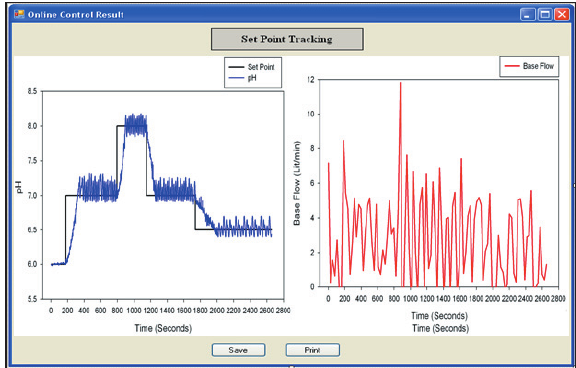
Figure 15: Set point tracking of pH neutralization process (PID